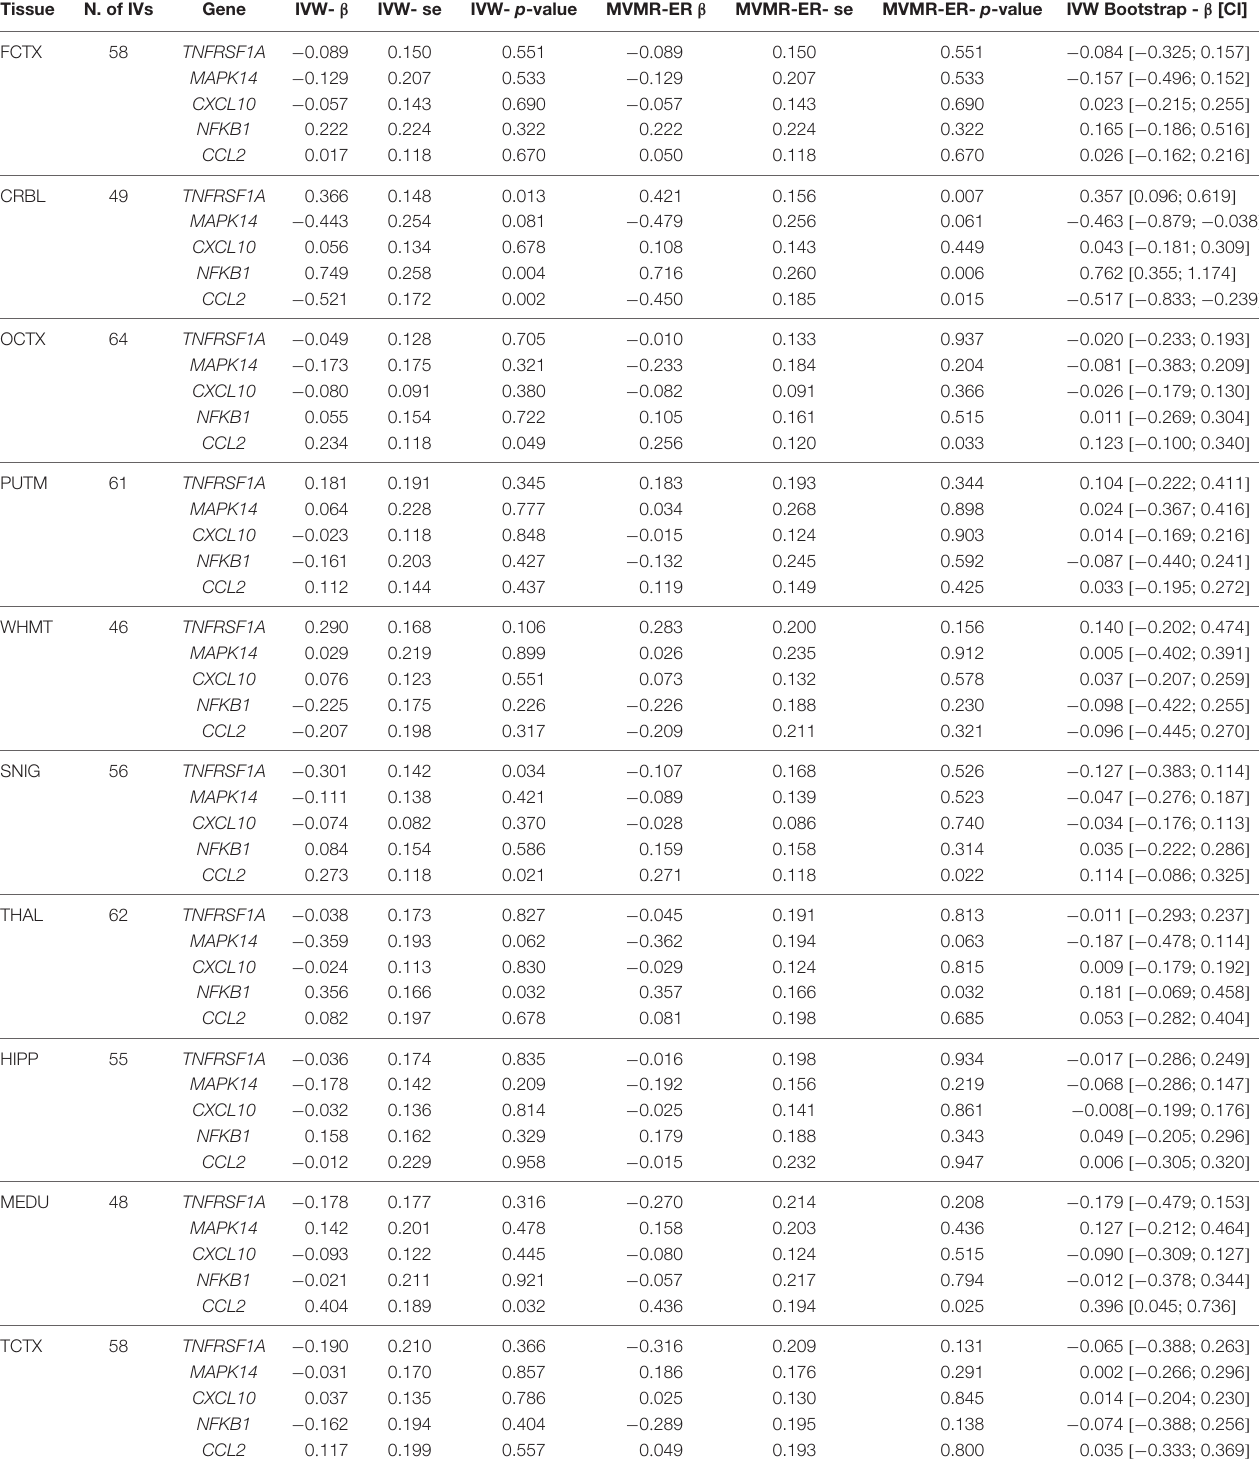
TABLE 4 | Direct effect of the 5 genes in each brain region via Multivariable MR analysis.